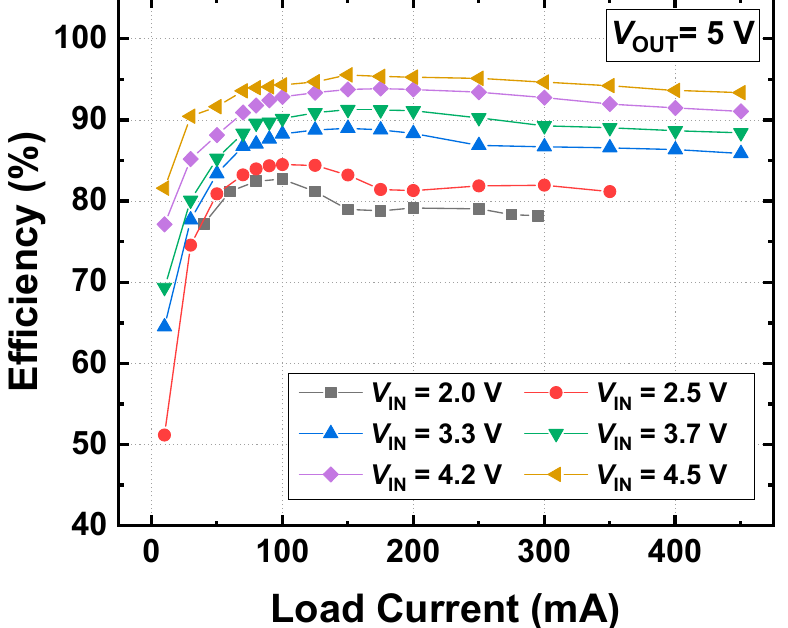
Figure 13. Load transient response.